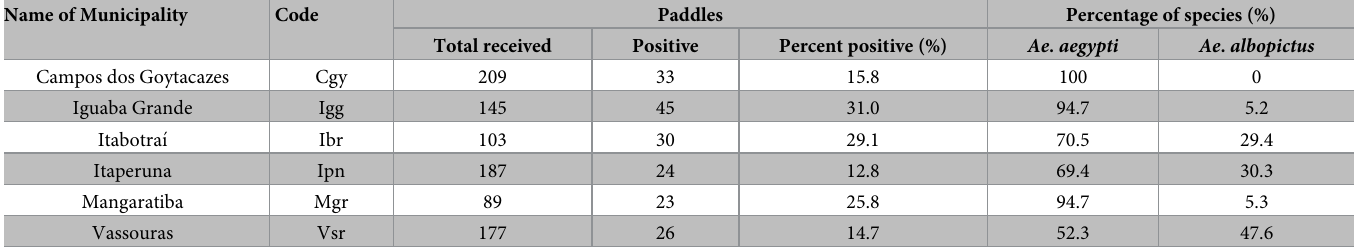
Table 2. Paddles’ positivity rate and percent of Aedes aegypti and Aedes albopictus adults. Paddles’ positivity percentage means the paddles with Aedes spp. eggs attached to it, out of total paddles received by the lab. The last column shows the percentage of adults of each species, Ae . aegypti and Ae . albopictus . We screened adults to their species based on morphological characters soon after they